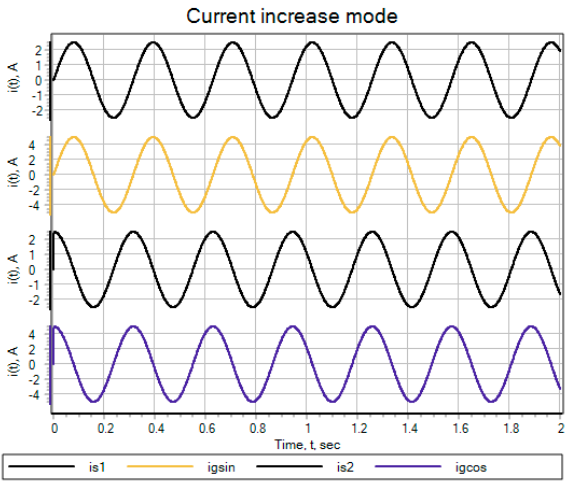
Figure 20. Voltage across the generator windings.